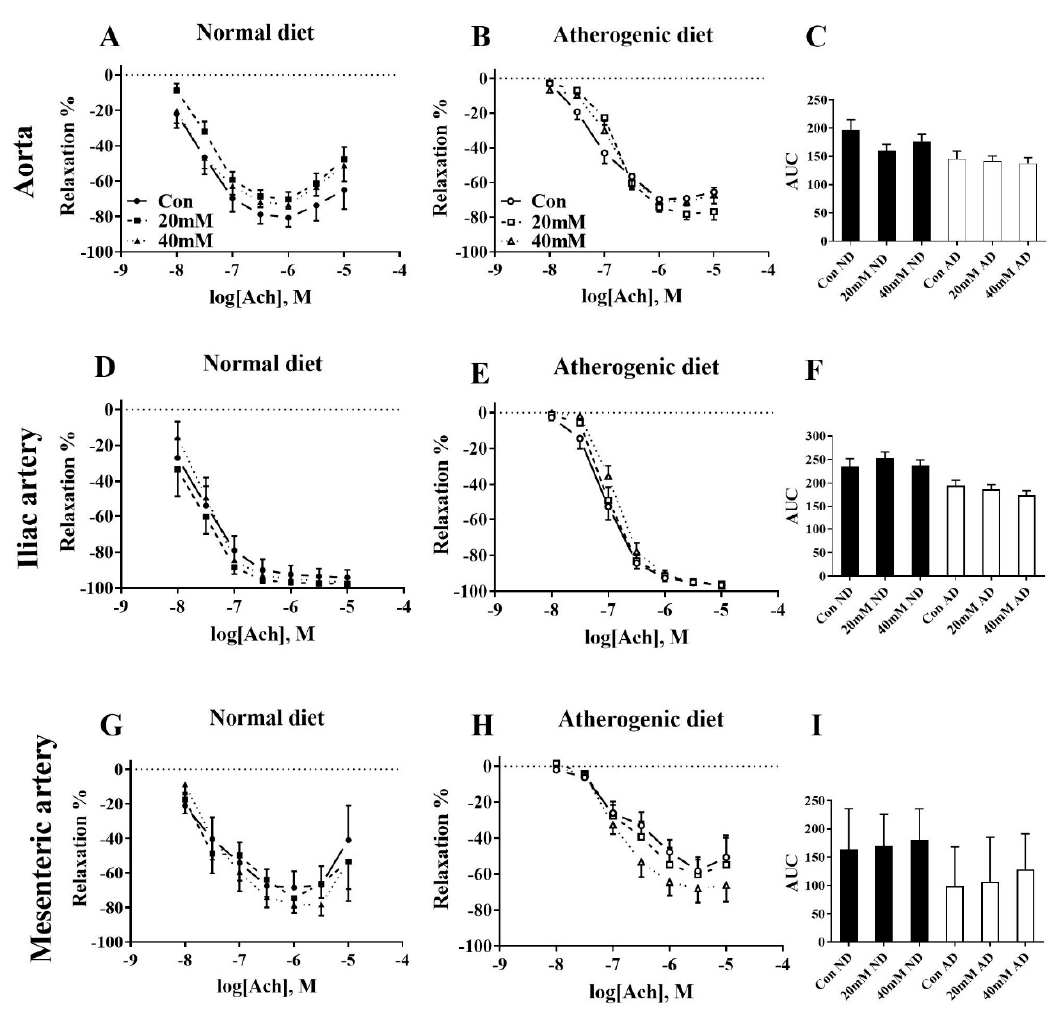
Figure 2. Ach-induced endothelium-dependent dose response curves in abdominal aorta ( A , B ), iliac artery ( D , E ), and mesenteric artery ( G , H ) incubated ex vivo for 2 h in respective solution. Comparison between Con (circles + line), 20 mM (squares + dashes), and 40 mM (triangles + dots). AUC ( C , F , I ) presented as arbitrary values. n = 6–12 per group. All data mean ± SEM. Con: normal Krebs; 20 mM: 20 mM glucose Krebs; 40 mM: 40 mM glucose Krebs; ND: normal diet; AD: atherogenic diet; AUC: area under the curve; Ach: acetylcholine. Table 1. Log EC 50 , E max and AUC results from ND and AD fed rabbits incubated ex vivo for 2 h in control, 20 mM, or 40 mM glucose solution.